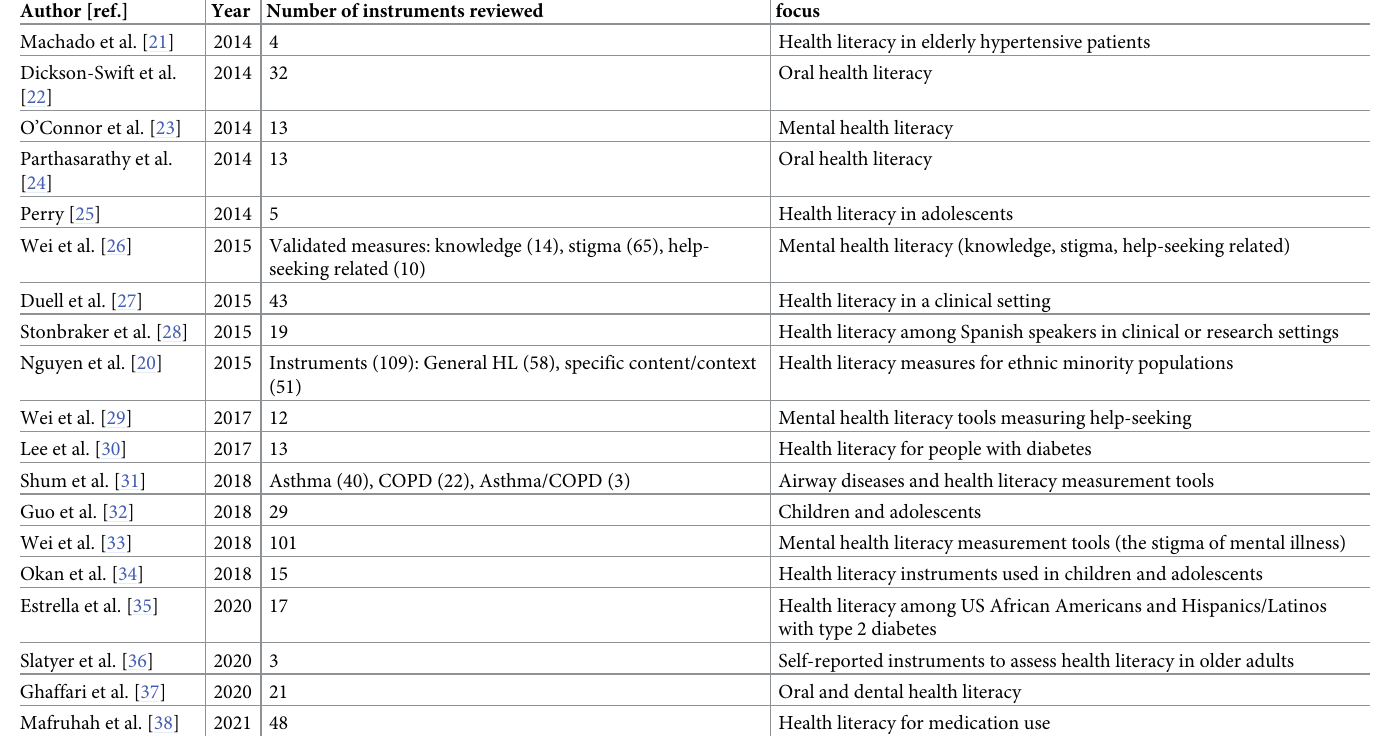
Table 1. Review papers on health literacy